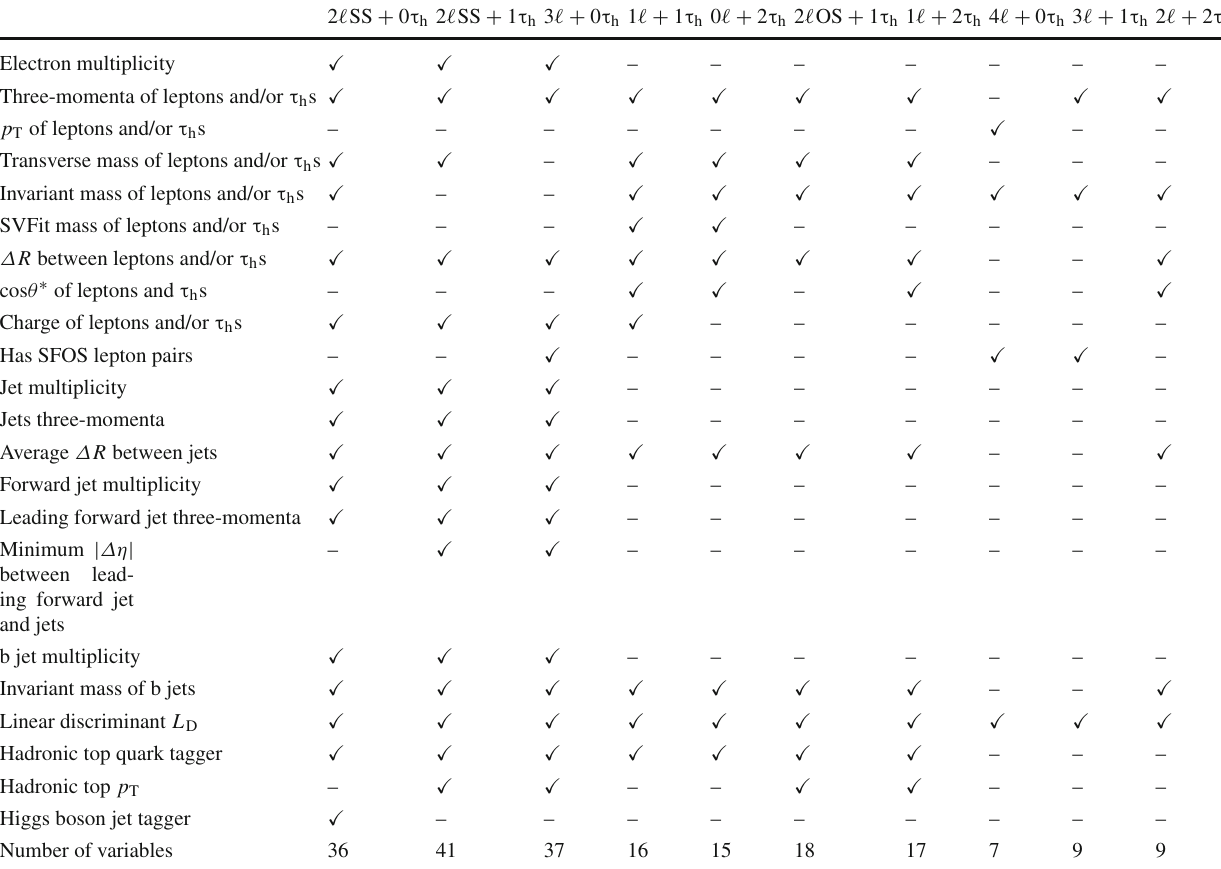
Table 5 Input variables to the multivariate discriminants in each of the ten analysis channels. The symbol “–” indicates that the variable is not used. For all objects, the three-momentum is constituted by the p T , η , and φ components of the object